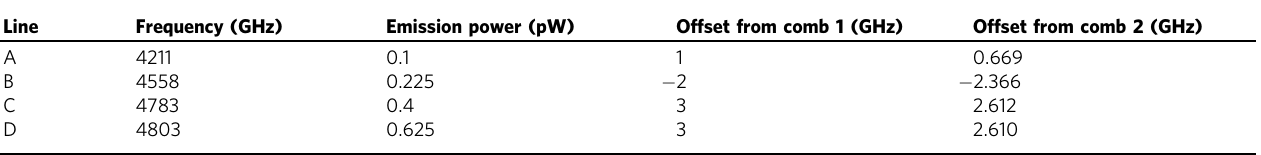
Table 1 Simulated spectral parameters corresponding to Fig. 3.